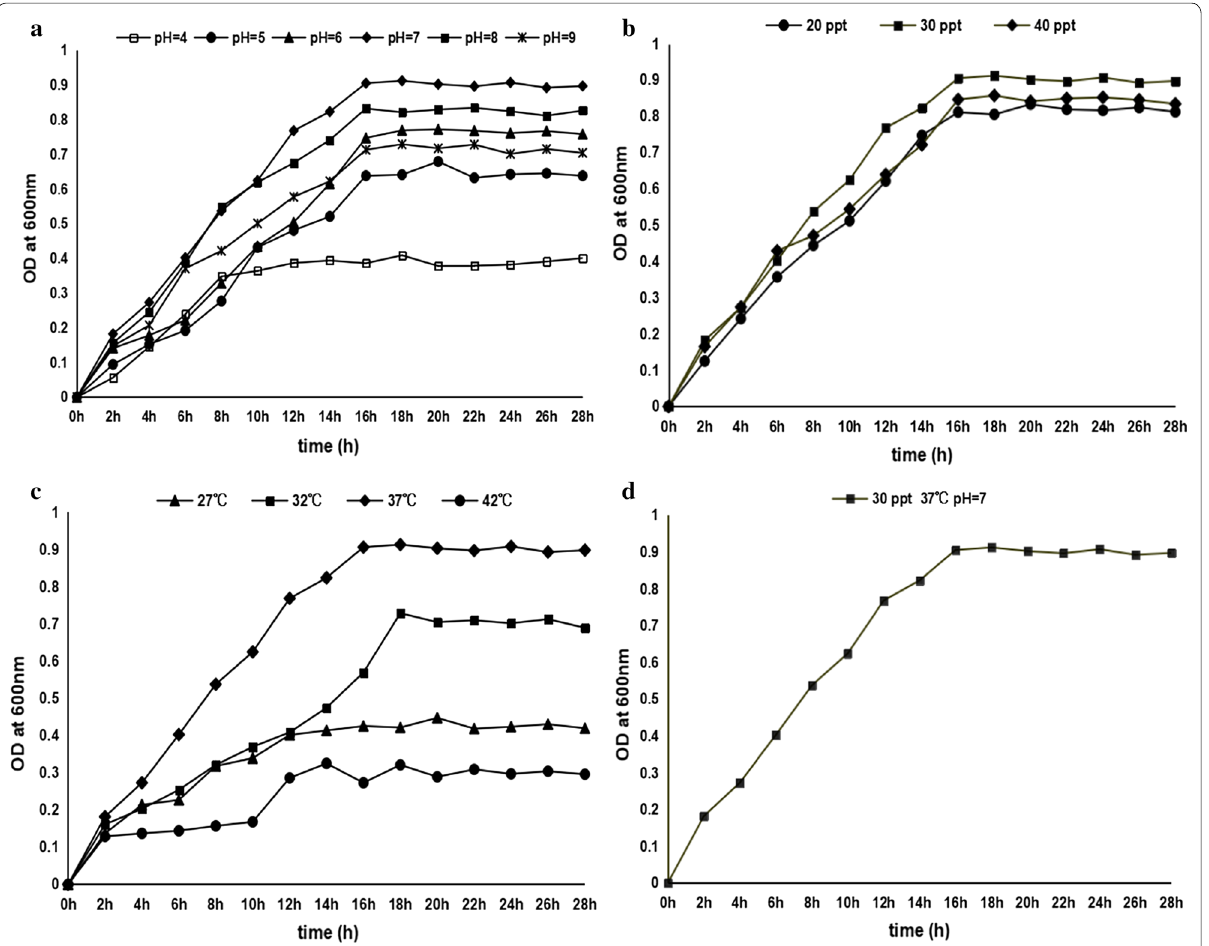
Fig. 3 Growth characteristics of the bacterial strain R8. a Growth under the conditions of 20–40 ppt. b Growth under the conditions of pH 5.0–9.0. c Growth at the temperatures of 27 °C, 32 °C, 37 °C and 42 °C. d The growth curve of the bacterial strain R8 under the condition of pH 7.0, 37 °C,